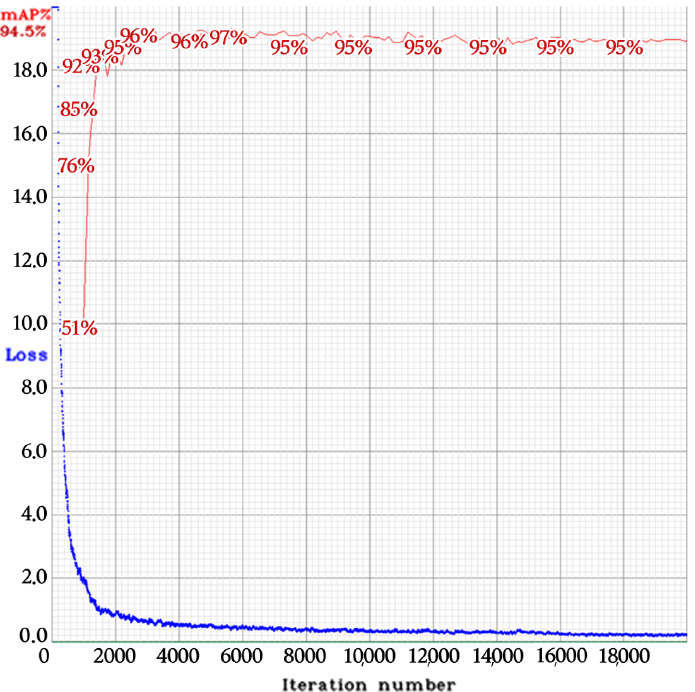
Figure 9. Training loss (blue) and mAP @ 0.5 (red) of the VT_LP detector in phase